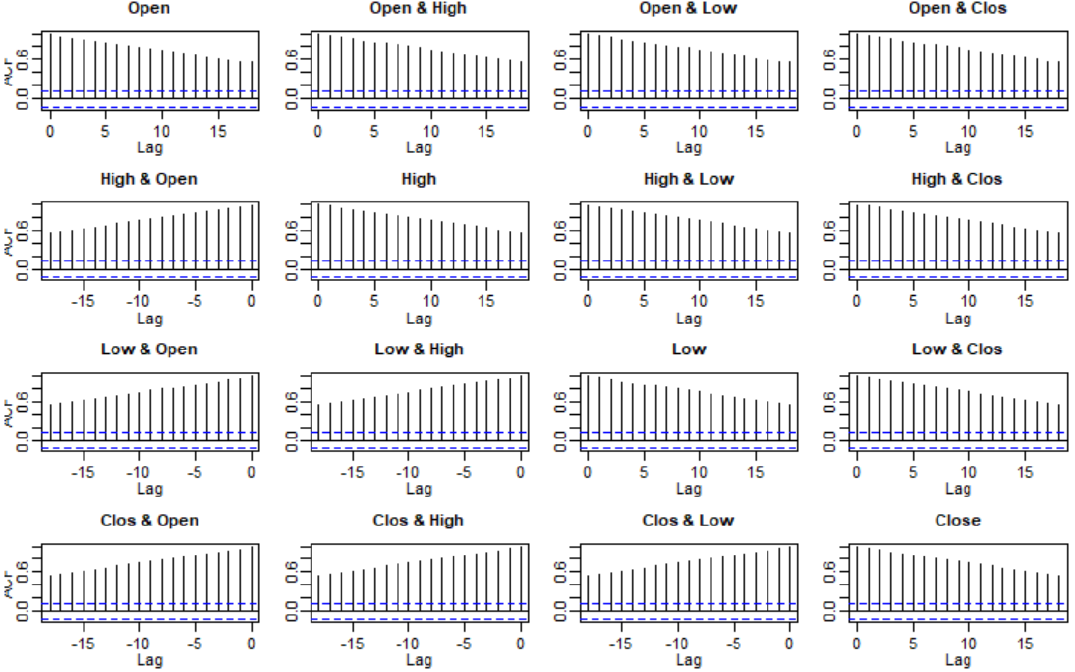
Figure 1. ACF test for correlation between open, low, high, and close of Apple stock daily prices from